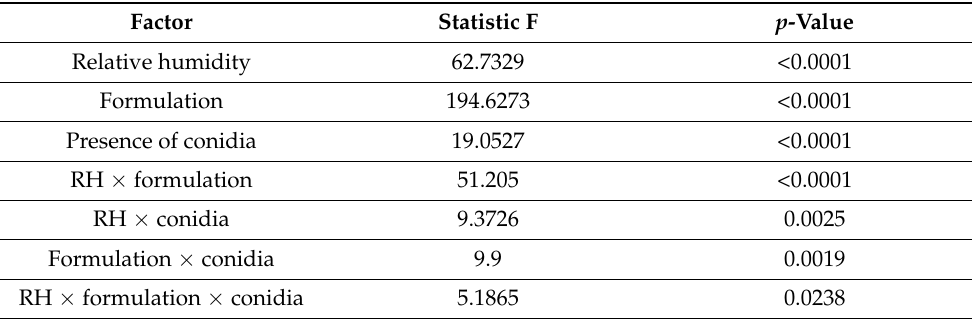
Table 3. Statistical significance of the effect of all fixed variables and their interactions on mortality